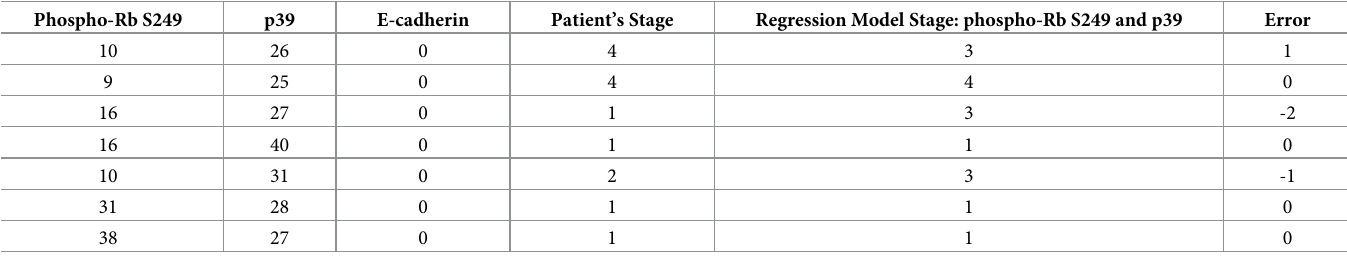
Table 8. A random sample of SCC tumors from our TMAs were selected to calculate tumor staging using our linear regression model when considering only E-cad- herin score. The tables show the score for phospho-Rb S249, p39, E-cadherin and the patient´s tumor stage ( first fourth columns , respectively ). The fifth column shows the stage predicted by our linear regression analysis when considering phospho-Rb S249 and p39 scores together. The Error (sixth) columns in all five tables show the differ- ence between the vendor score and our linear regression analysis score, a value of 0 indicating identical scores, while a number other than 0 means that the two scores were different by a magnitude equal to the number indicated in the column. The combined scores of phospho-Rb S249 and p39 accurately predicted the stage in 4 out of 7